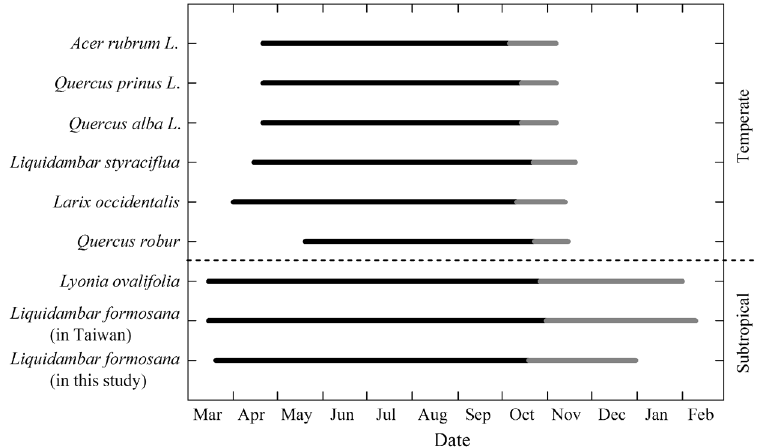
Figure 5. Comparison of leaf life span (estimated from leafy to leafless) between L . formosana and other subtropical and temperate deciduous tree species. Gray lines represent the leaf senescence periods for each species. Data for Lyonia ovalifolia are from Zhang et al . 9 , Liquidambar formosana from Wen et al . 42 , Quercus robur from Morecroft et al . 36 , Larix occidentalis from Rosenthal et al . 37 , Liquidambar styraciflua from Herrick et al . 16 , Quercus alba L ., Quercus prinus L . and Acer rubrum L . from Wilson et al . 51 .